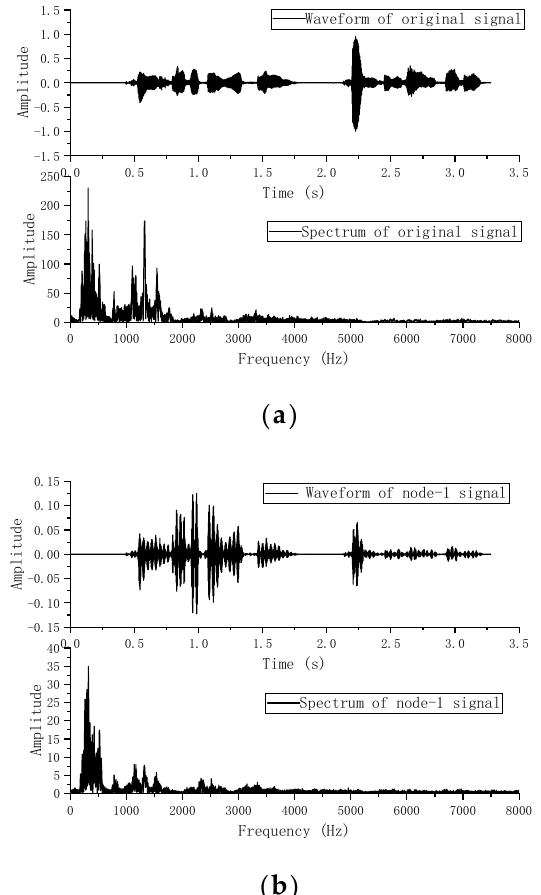
Figure 4. ( a ) The waveform and spectrum of the original speech signal, and ( b ) the waveform and spectrum of node 1 speech signal.